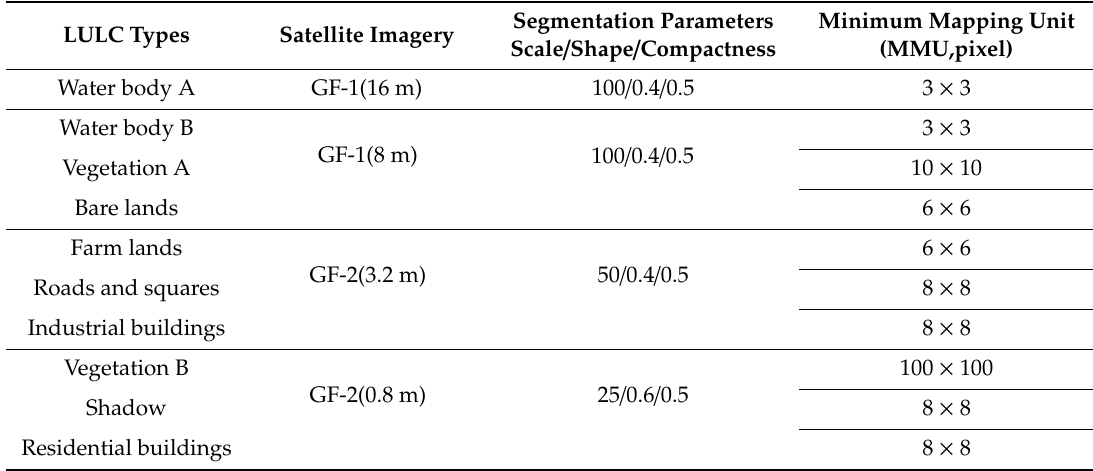
Table 4. Minimum mapping unit (MMU) and segmentation parameters for GF-1 and GF-2